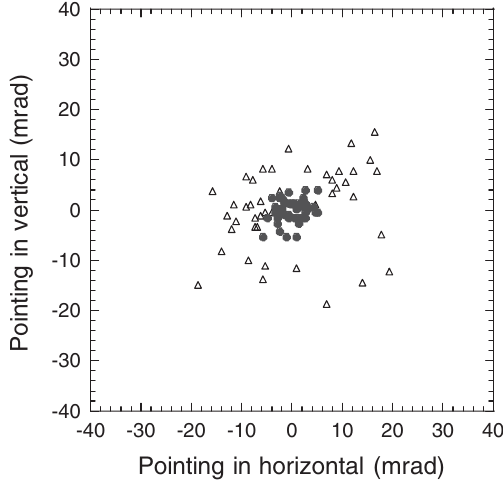
FIG. 3. Beam-pointing stability in He and Ar. Symbols corre- spond to the gas material: ( 4 ) helium and ( d ) argon. The neutral density was 2 : 2 (cid:3) 10 19 cm (cid:4) 3 in He and 5 : 0 (cid:3) 10 18 cm (cid:4) 3 in